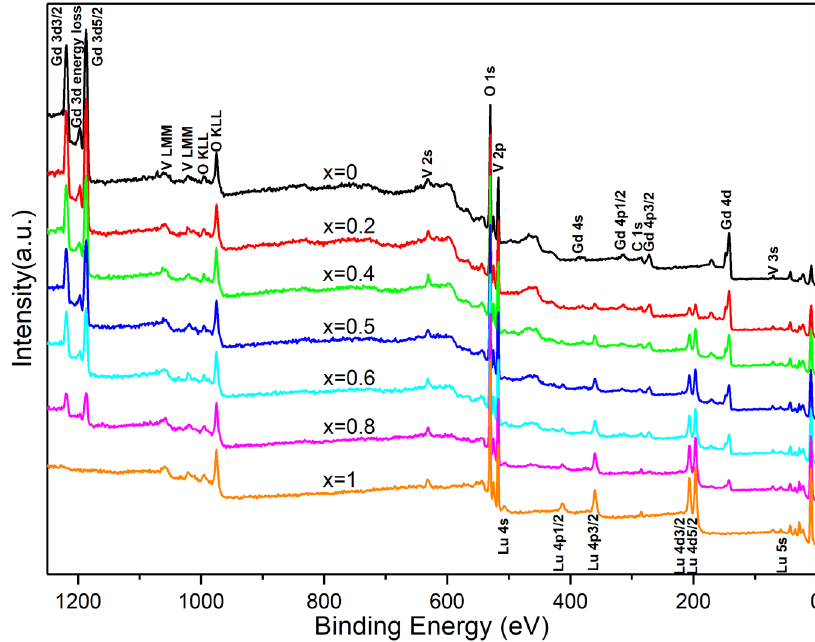
Figure 7. XPS survey spectra of Lu x Gd 1 − x VO 4 ( 0 ≤ x ≤ 1) nanocrystals.